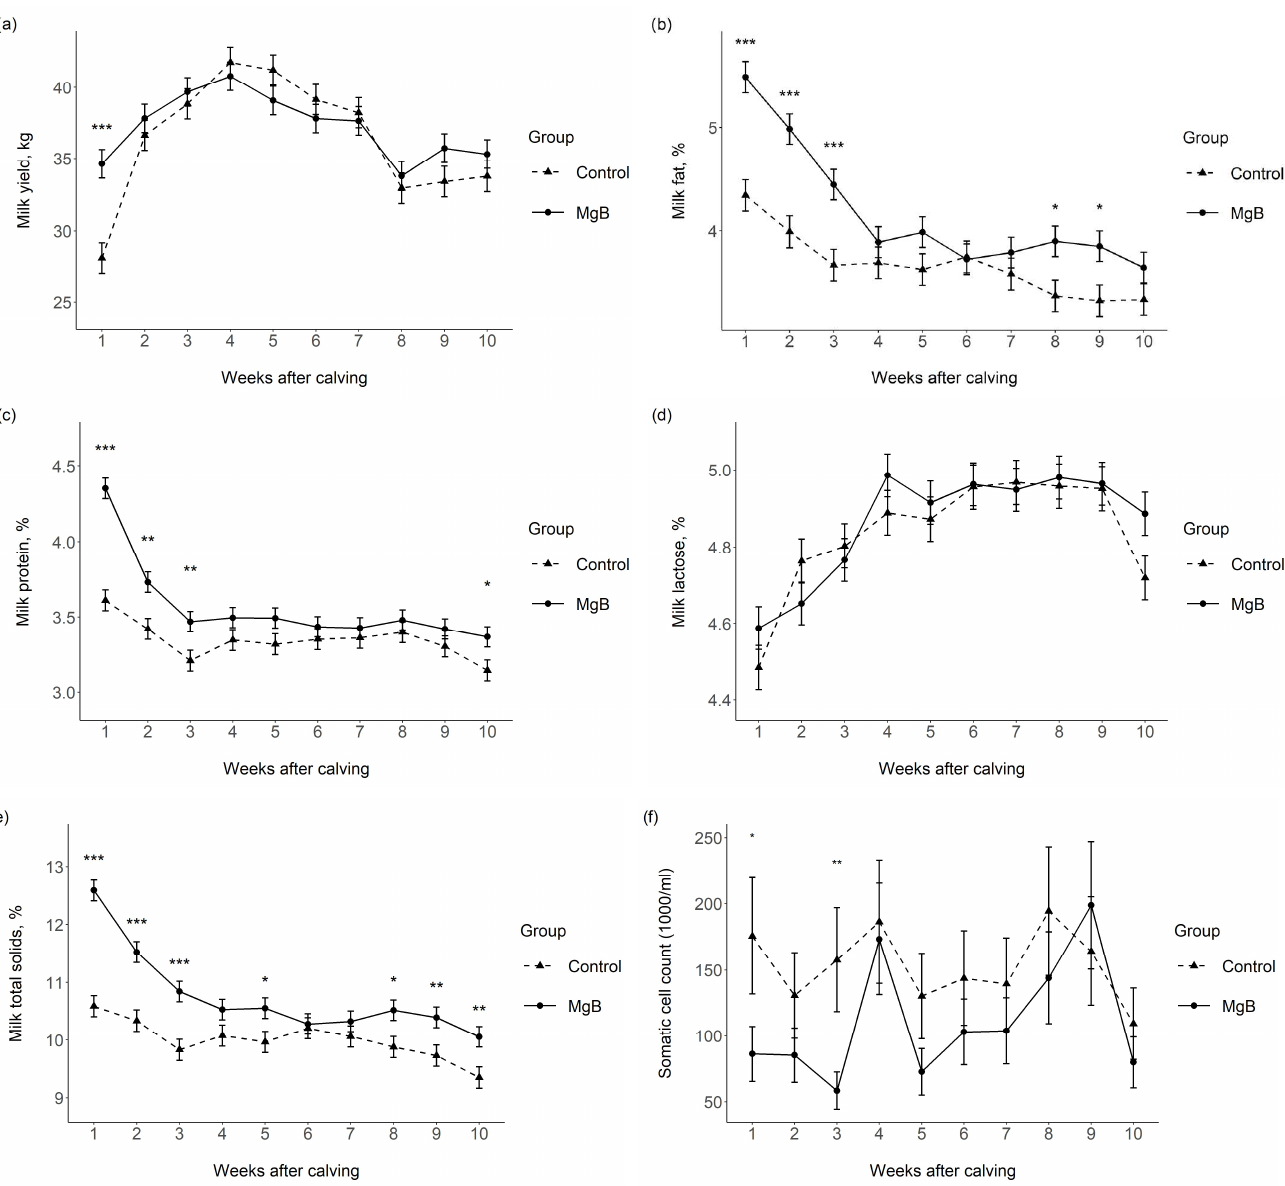
Figure 1. Changes in milk ( a ) yield, ( b ) fat, ( c ) protein, ( d ) lactose, ( e ) total solids, and ( f ) somatic cell count over the first 10 weeks of lactation of dairy cows with (MgB, n = 34) and without (Control, n = 31) prepartum magnesium butyrate supplementation. Data are presented as least squares means and standard errors. For SCC, estimates are back transformed from the logarithmic scale. Significant differences are indicated on individual time points within each chart (* p < 0.05; ** p < 0.01; *** p < 0.001).